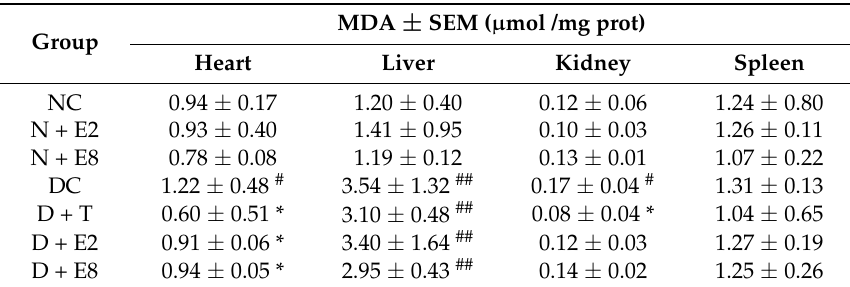
Table 3. Effects of ECE on MDA levels in organs of normal and diabetic rats. MDA ± SEM ( µ mol /mg prot) Group Heart Liver